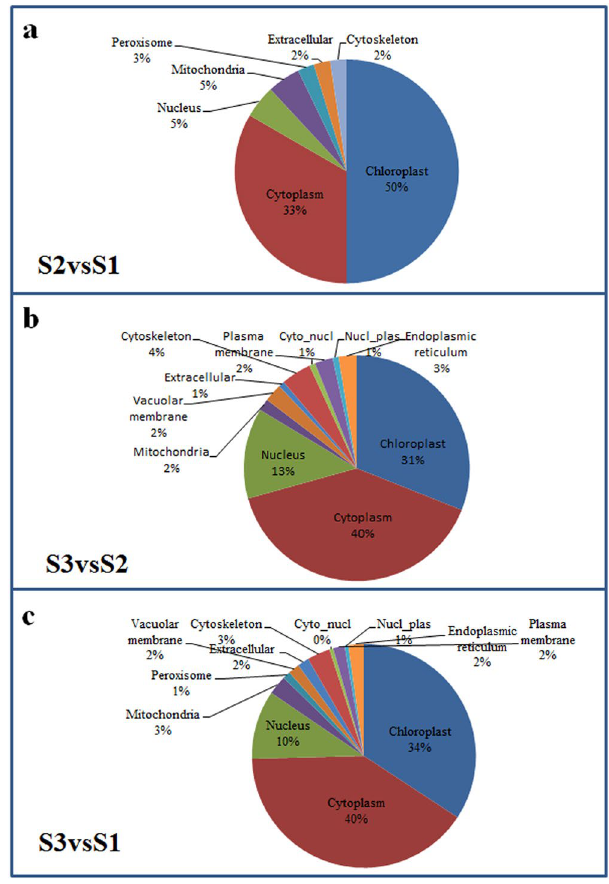
Figure 5. Subcellular location of PDSLs among the three ‘Anji Baicha’ developmental stages. ( a ) S2vsS1. ( b ) S3vsS2. ( c ) S3vsS1.